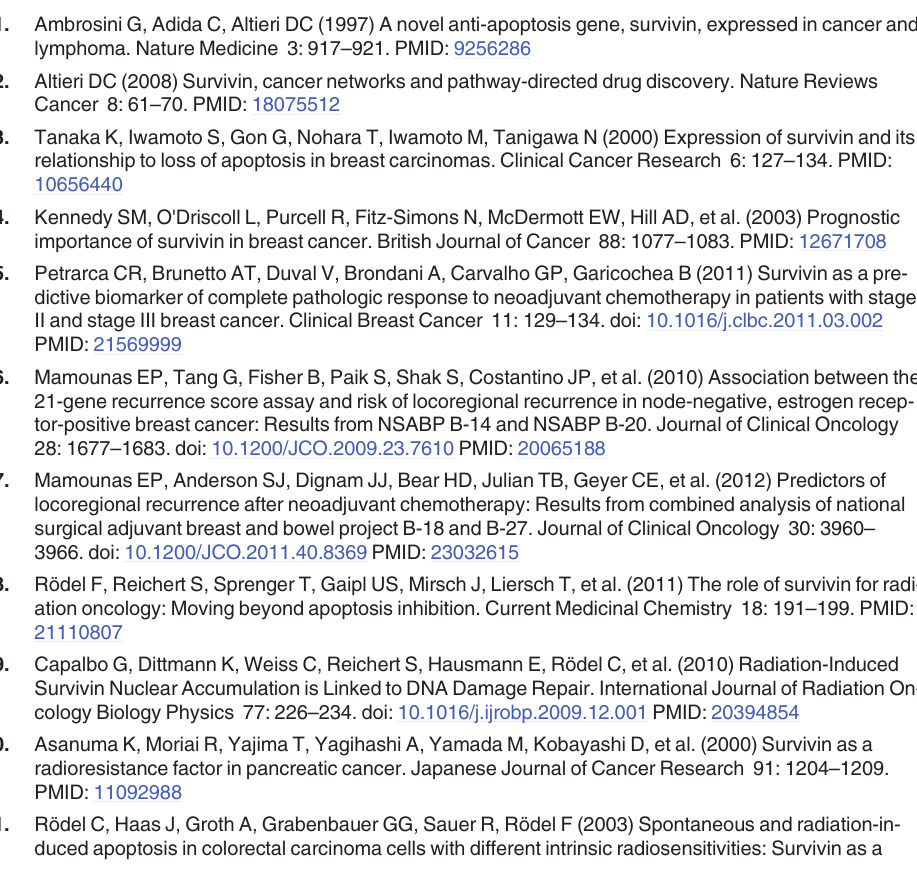
S1 Fig. Survivin activity in MCF7 and SUM149 xenograft tissue. (TIF) S2 Fig. Staining of SUM149 primary tumor xenograft for survivin.